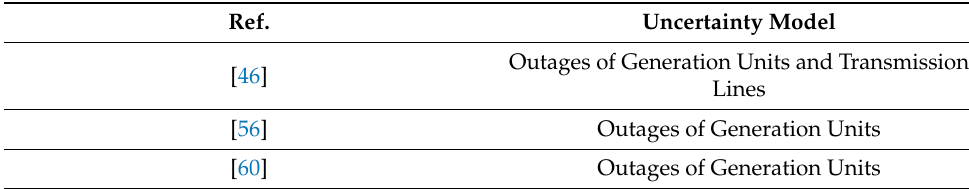
Table 9. Studies In Which MCMS Is Used.